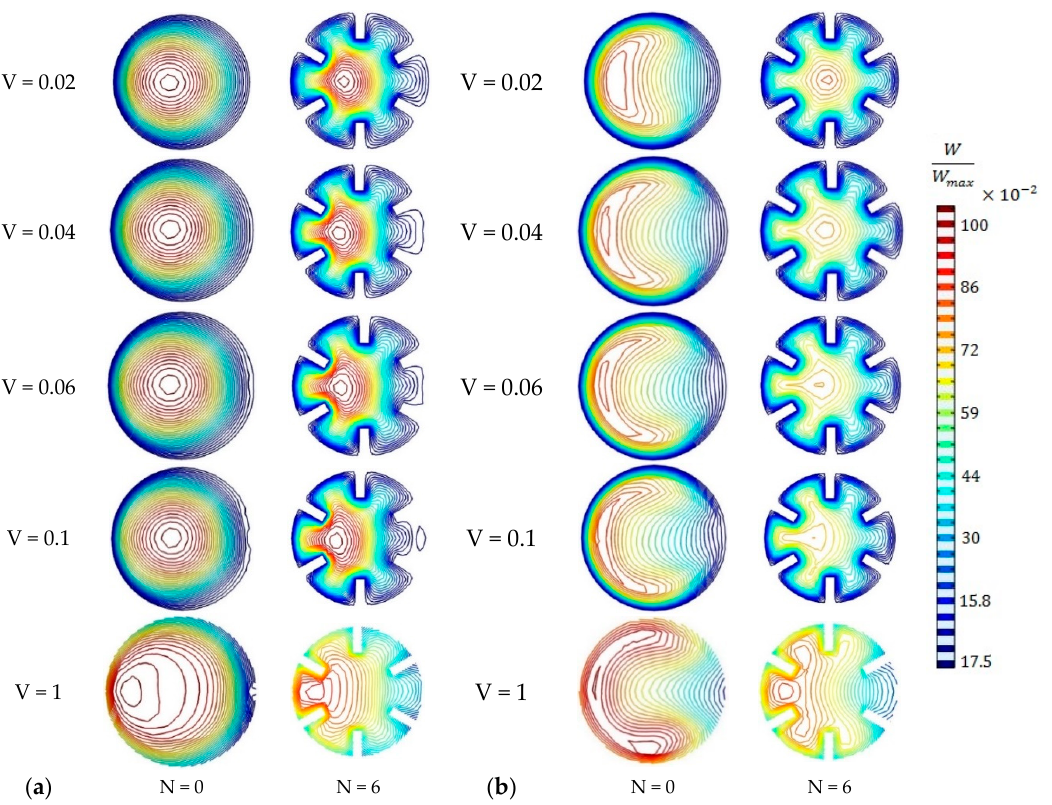
Figure 10. Axial velocity contours for smooth ( left ) and finned U-tube ( right ) at different velocities; ( a ) inlet pipe; ( b ) outlet pipe.